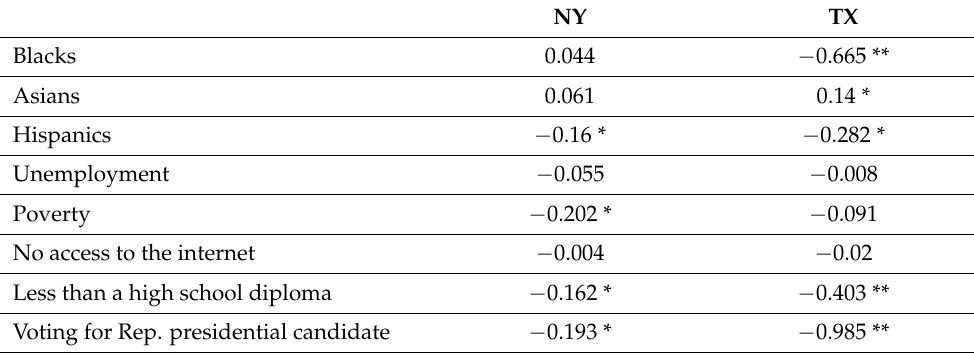
Table 4. Gaussian global regression on vaccination rates in both regions. NY TX Blacks 0.044 − 0.665